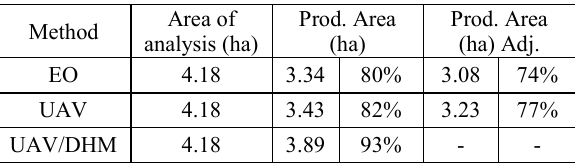
Table 1. Productive area results comparison